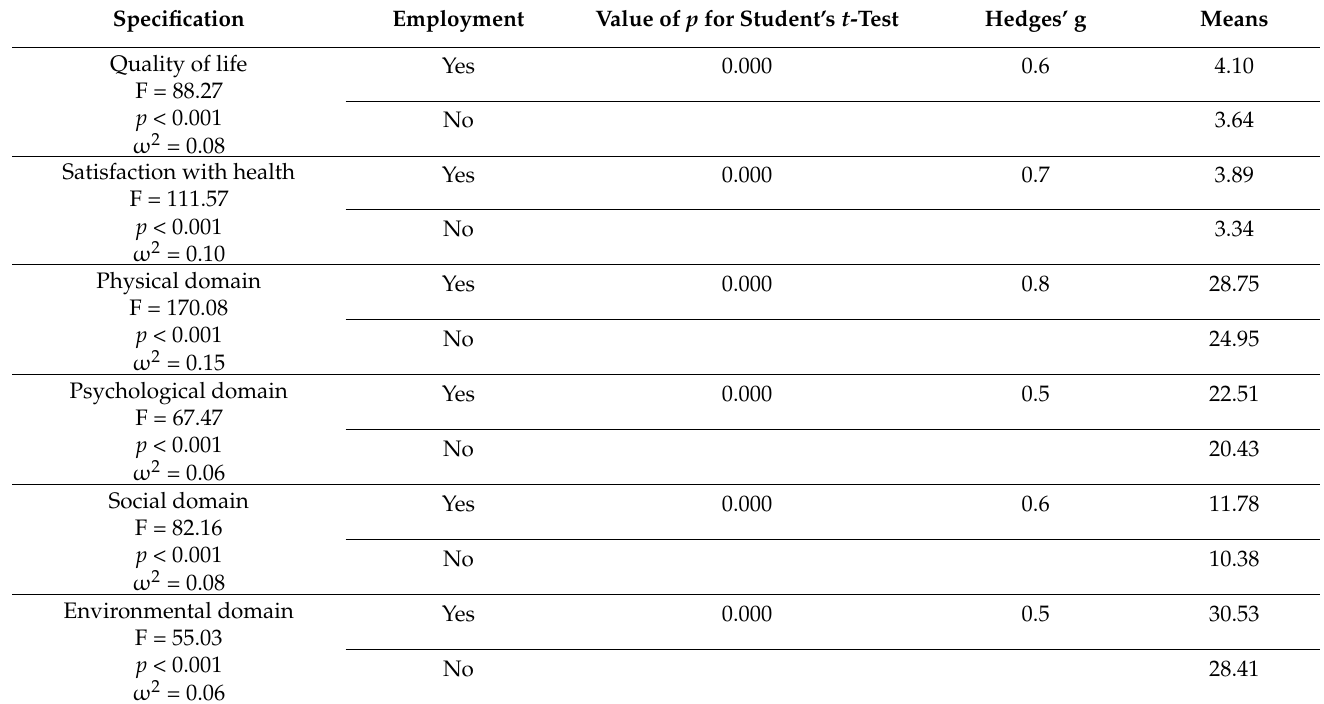
Table 5. Employment and quality of life for students, their parents, and their grandparents (F-test, ω 2 , t -test, Hedges’ g). Specification Employment Value of p for Student’s t -Test Hedges’ g Means Quality of life